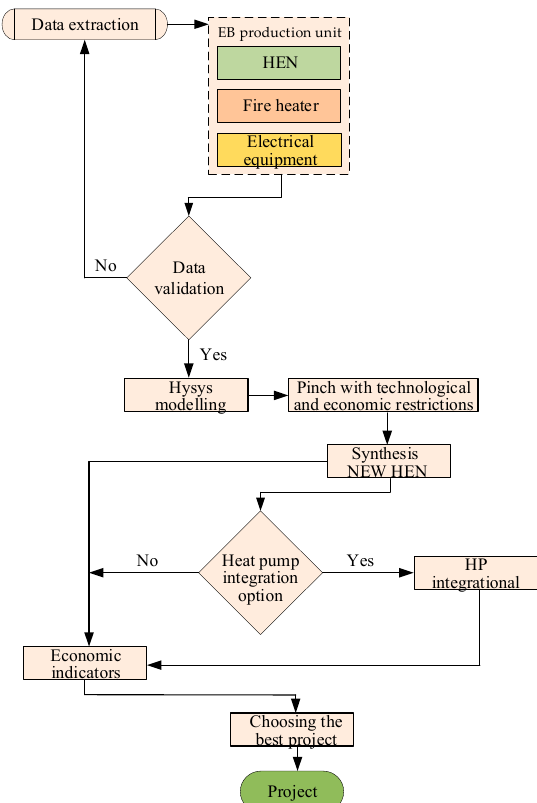
Figure 1. The block diagram of the